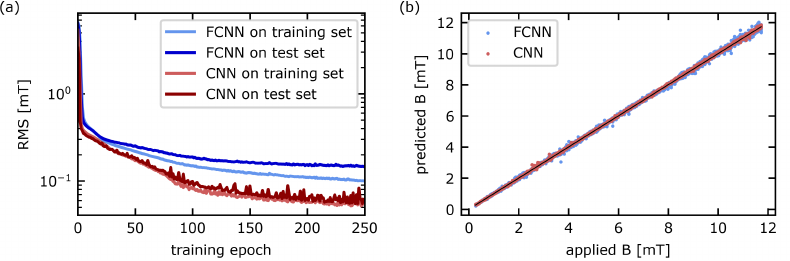
Figure 6. Comparison of fully connected (FCNN) and convolutional (CNN) network architectures for analysis of ODMR spectra. ( a ) shows the root-mean-square error (RMS) on the training and test set during the training process. ( b ) shows the predicted B field value depending on the “true” B field for 2500 randomly selected spectra from the test and training set.